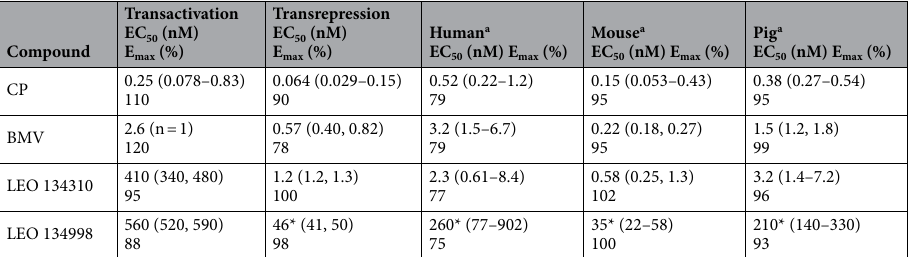
Table 3. In vitro potency of LEO 134310 and comparison to CP and BMV. GR agonist-induced transactivation of mouse mammary tumour virus (MMTV) promoter in HeLa cells and PMA-induced, GR-mediated transrepression of human Matrix Metallopeptidase 1 (MMP1) promoter in HeLa cells of LEO 134310 (n = 2), its major metabolite, LEO 134998 (n = 2), CP (n = 6–7) and BMV (n = 1–2). Inhibition of LPS-induced TNF-alpha release in PBMCs a isolated from Human, Mouse, and Pig whole blood. LEO 134310 (n = 15, 2, 2), its major metabolite, LEO 134998 (n = 10, 3, 5), CP (n = 17, 4, 4) and BMV (n = 15, 2, 2). Geometric mean (95% confidence intervals within brackets for n > 2. For n = 2 individual results are shown. *p < 0.05 compared to LEO